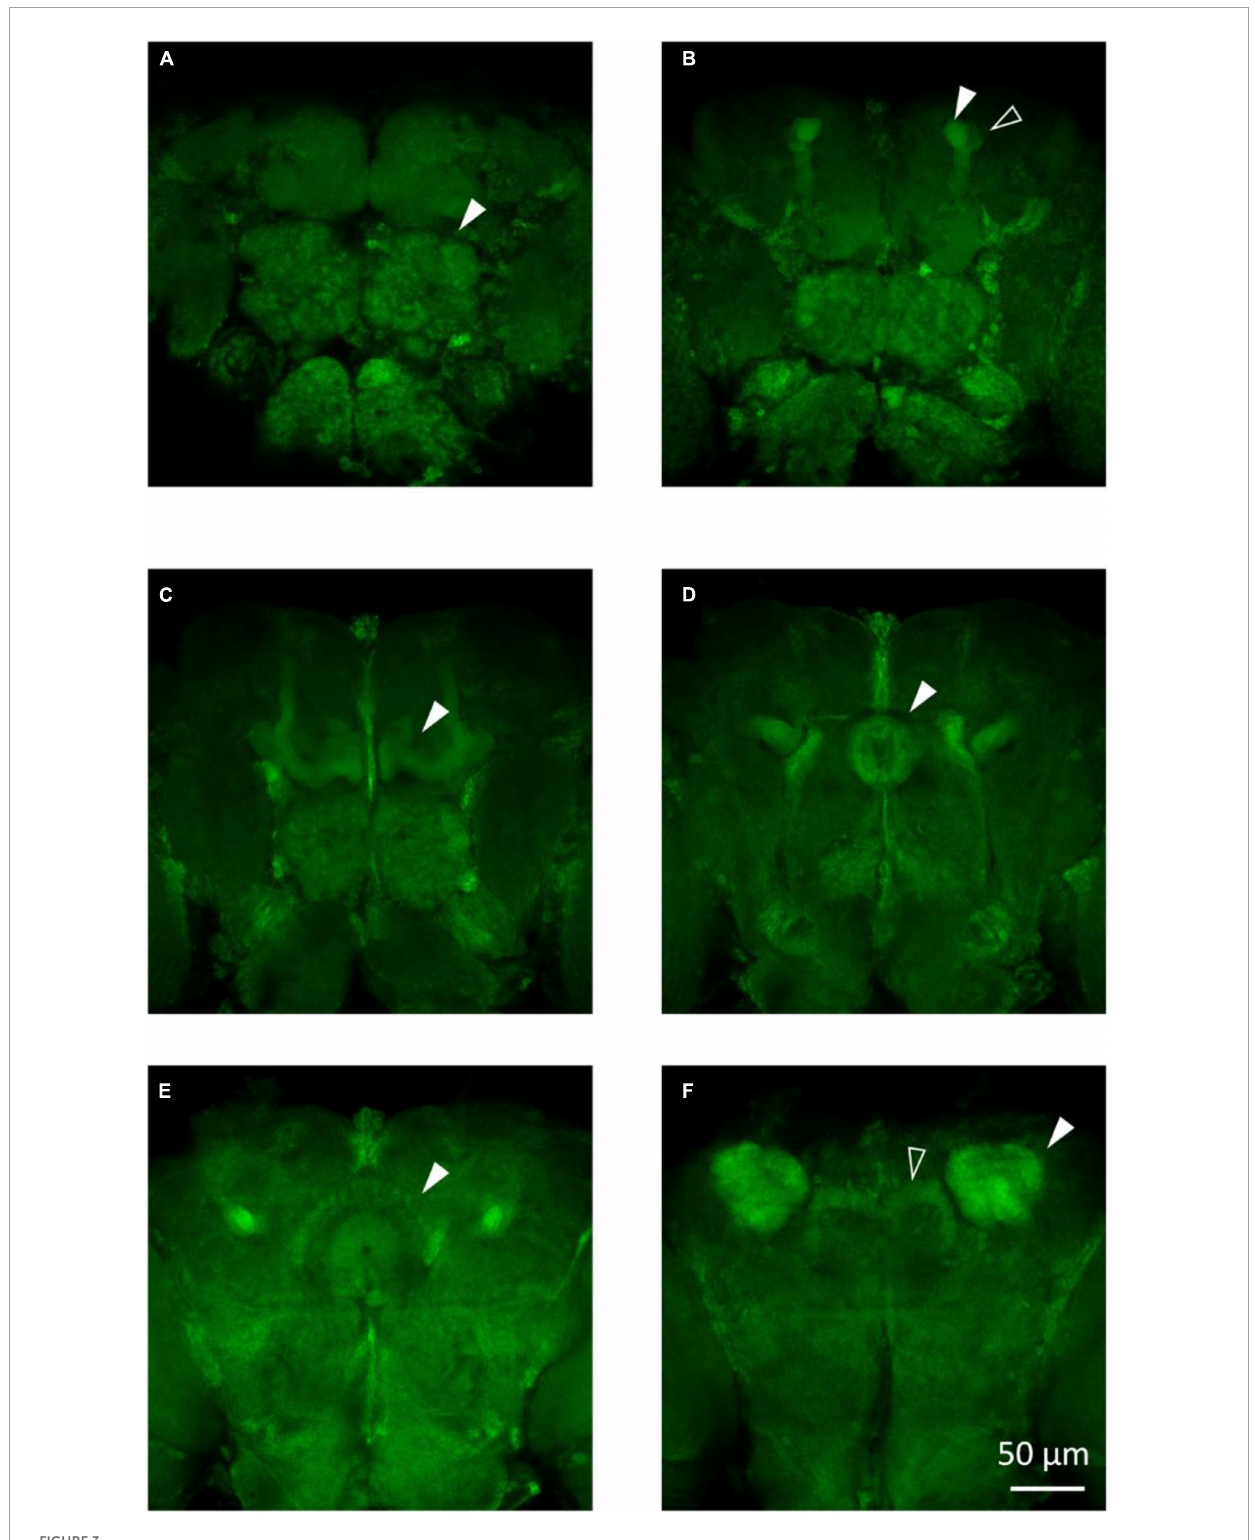
FIGURE3 The main structures in the fly brain. (A) Antennal lobes are indicated by the arrow in the anterior view of the tub-Gal4 > UAS-mCD8:GFP fly brain. (B) Alpha lobe (solid arrow) and alpha’ lobe (hollow arrow) of the mushroom body are shown in the anterior view of the fly brain. (C) Gamma lobe of the mushroom body in the tub-Gal4 > UAS-mCD8:GFP fly brain. (D) Ellipsoid body of the central complex in the tub-Gal4 > UAS-mCD8:GFP fly brain. (E) Fan-sharp body of the central complex in the tub-Gal4 > UAS-mCD8:GFP fly brain. (F) Protocerebral bridge (hollow arrow) of the central complex and calyx (solid arrow) of the mushroom body are shown in the posterior view of the fly